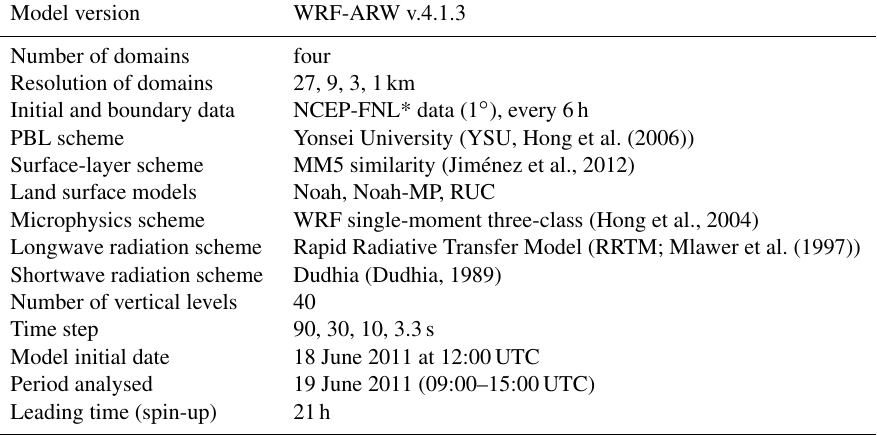
Table 1. Details about the WRF model configuration common to all simulations. *National Centers for Environmental Protection